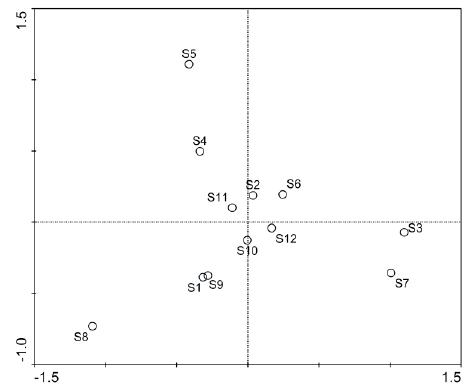
Figure 4. PCA biplot of spatial distribution characters for plankton community in Lake Nansihu. S1 to S12 were standing for the 12 sample sites in the lake.